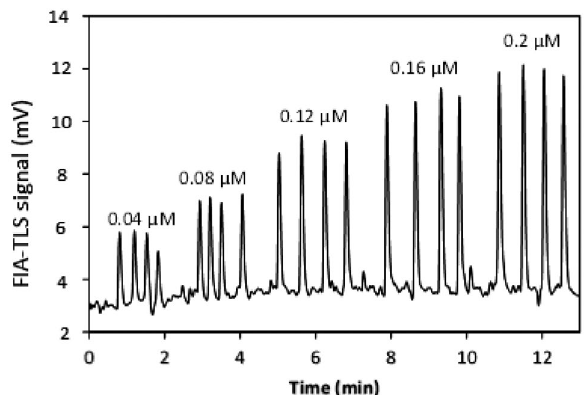
Figure 9. FIA-TLS signals for replicate injections of [Fe(PHN) 3 ] 2+ at different